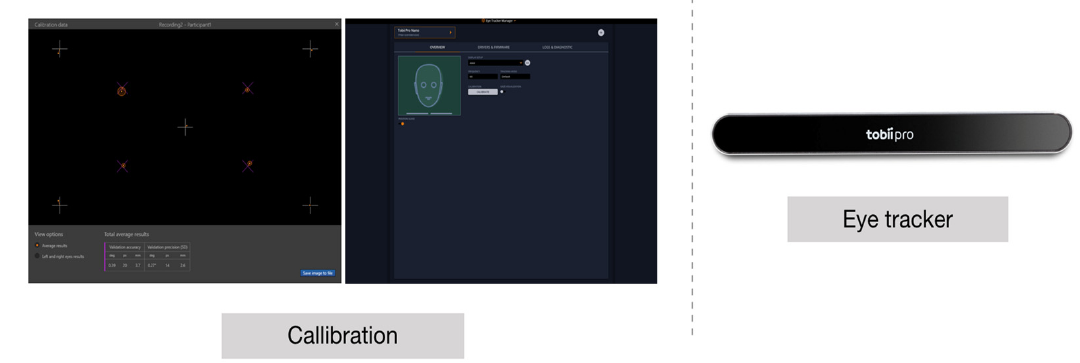
Figure 3. Calibrating and validating the eye tracker.